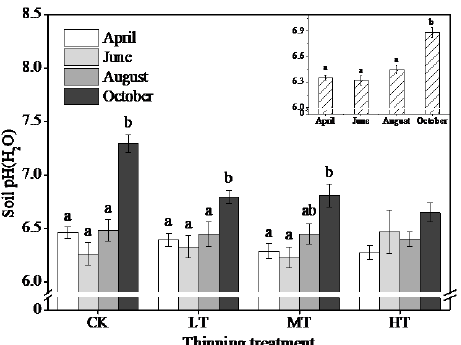
Figure 8. Effects of sampling times on soil pH in four thinning treatments in L. principis-rupprechtii plantations. CK, control site; LT, light thinning; MT, moderate thinning; HT, high thinning. Error bars indicate standard error ( n = 9), i.e., three plots repeats × three soil depths. Values within each treatment followed by different letters differ significantly according to Tukey's test ( p <0.05). When the difference was not statistically significant, no letter notation was noted.